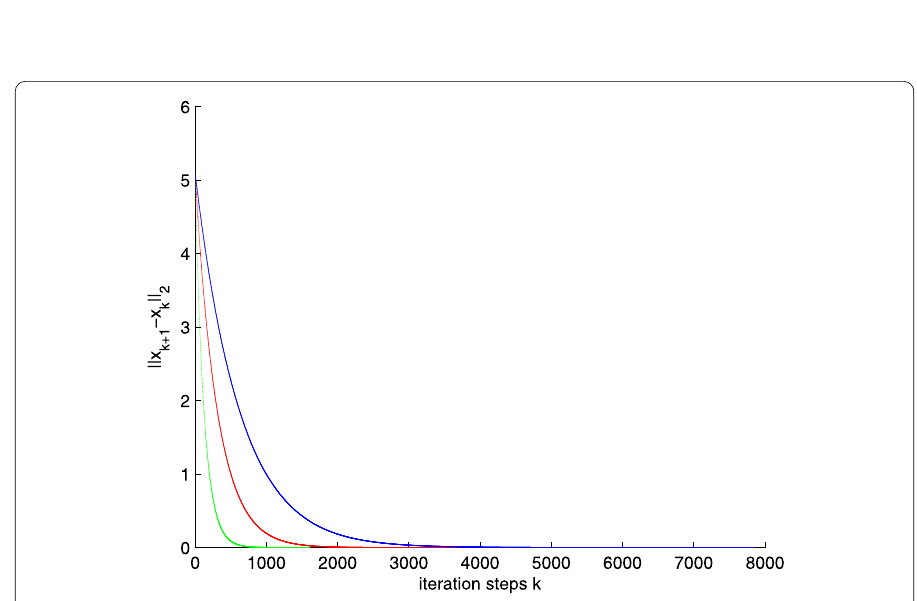
Figure 2 The convergent iteration steps with different α for Example 2. Each curve in this graph represents the convergent iteration steps for different α , with γ = 1 The yellow curve represents α = 5 × 10 –2 ; the red curve represents α = 2 × 10 –2 ; and the blue curve represents α = 1 × 10 –2